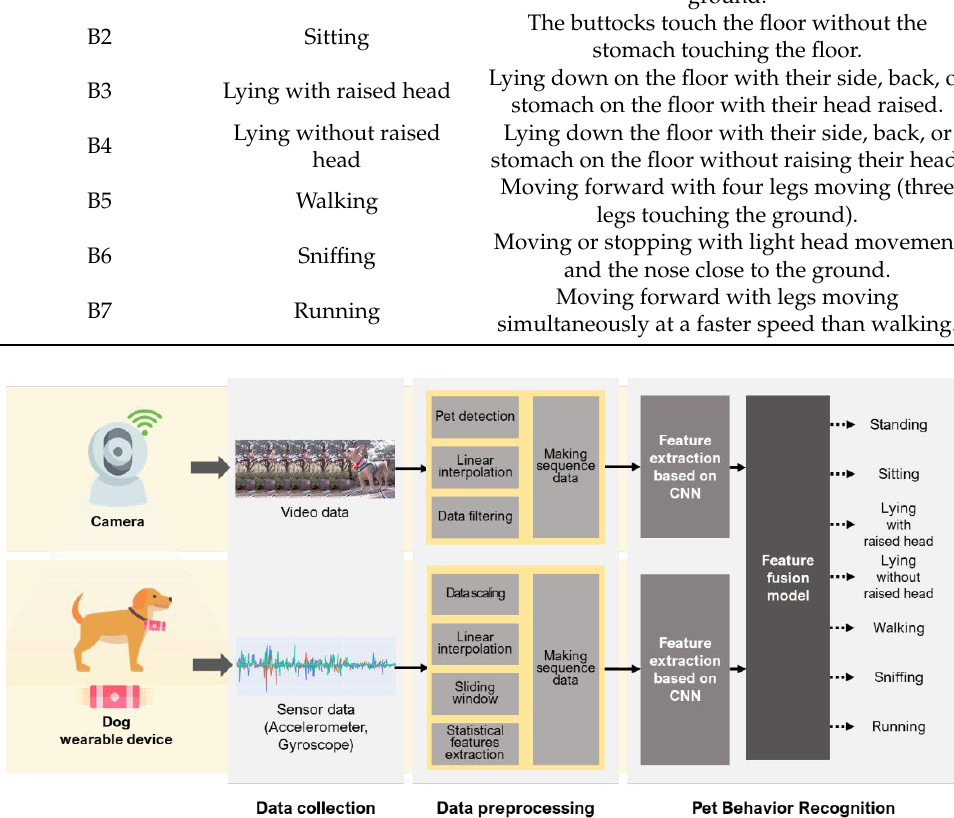
Figure 1. Process of dog behavior recognition based on multimodal